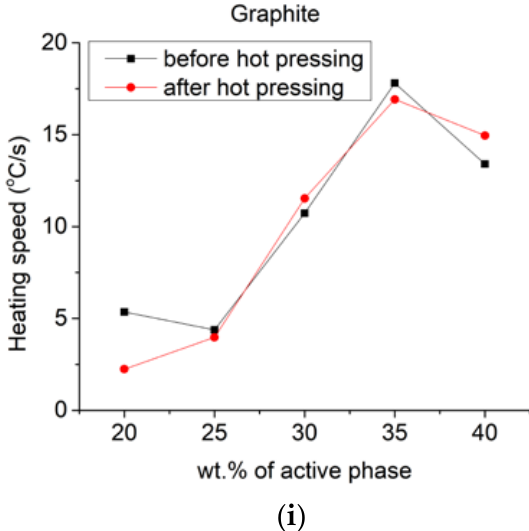
Figure 5. Results of evaluation of thermal properties of heaters made ( a,b,c ) with graphene nanoplatelets, ( d,e,f ) carbon black and ( g,h,i ) graphite showing the relation between wt.% of functional phase and: ( a,d,g ) power; ( b,e,h ) resulting temperatures; ( c,f,i ) heating speed; before and after hot pressing with an applied voltage of 40 V.